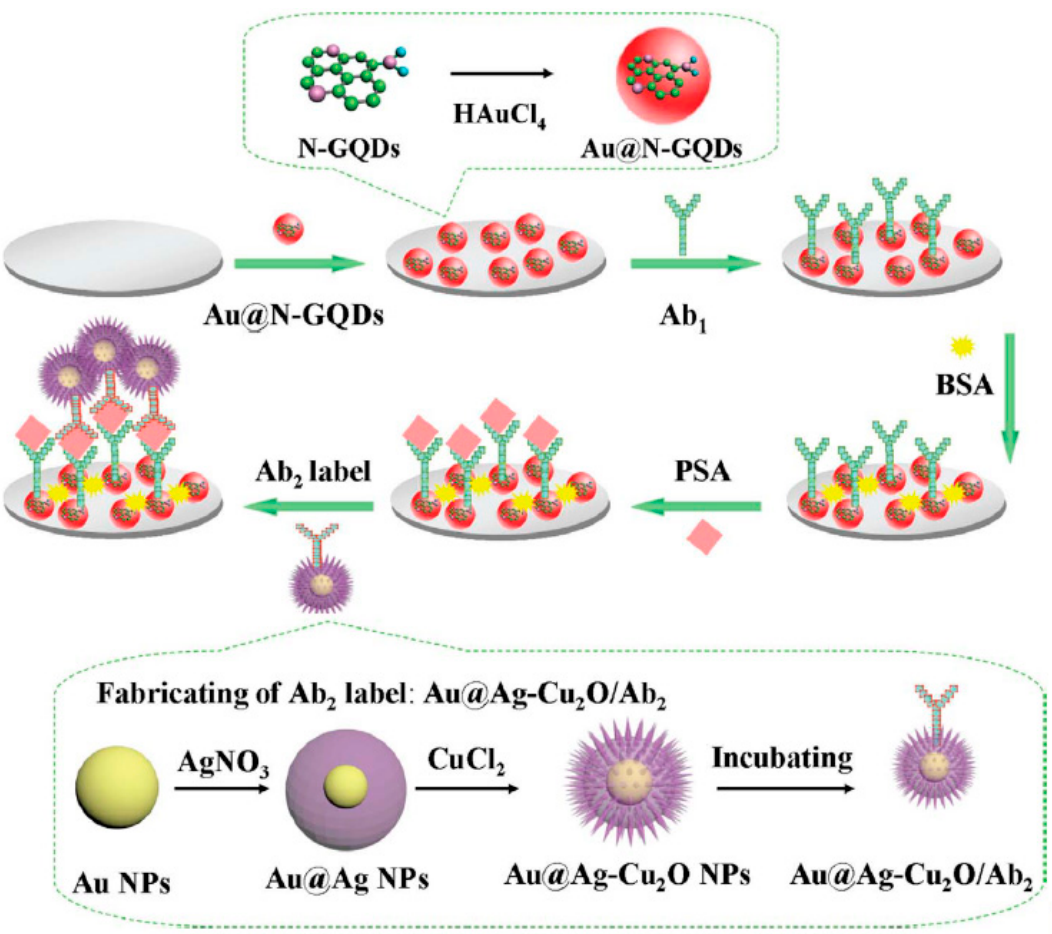
Figure 5. The schematic illustration of the sandwich-type electrochemical immunosensor and the preparation procedure of Au@N-GQDs NPs and Au@Ag-Cu 2 O/Ab 2 Reprinted with Permission [82].